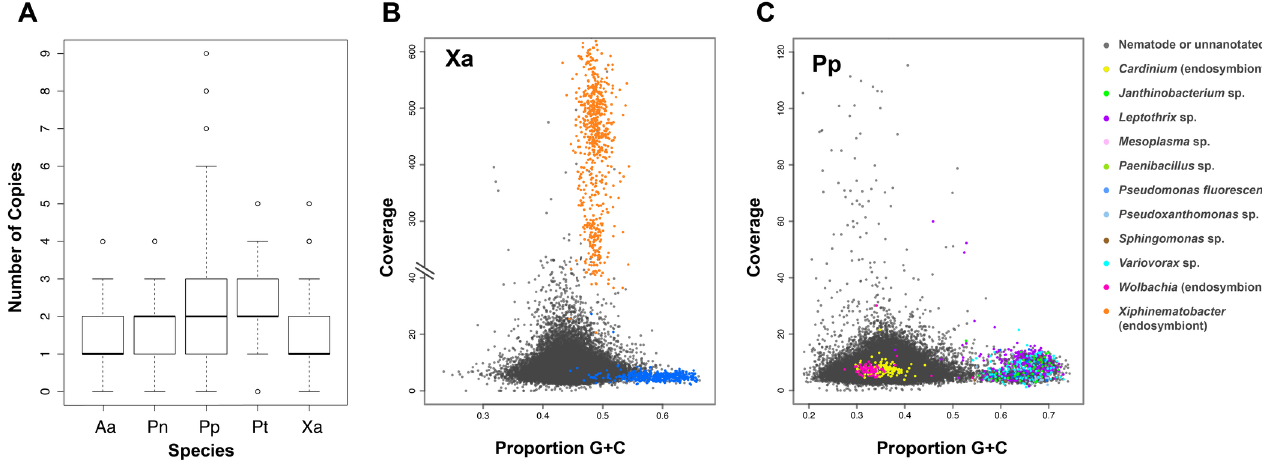
Fig 2. Box and blob plots. (A) Box plots reporting results for numbers of homologs detected for 65 highly conserved orthologs in 5 PPN species analyzed. Results for G . ellingtonae are not included because this species was found to encode a single homolog for all 65 orthologs. (B) and (C) Blob plot results for X . americanum and P . penetrans , respectively. Colors indicate BLAST matches to different species of bacteria.